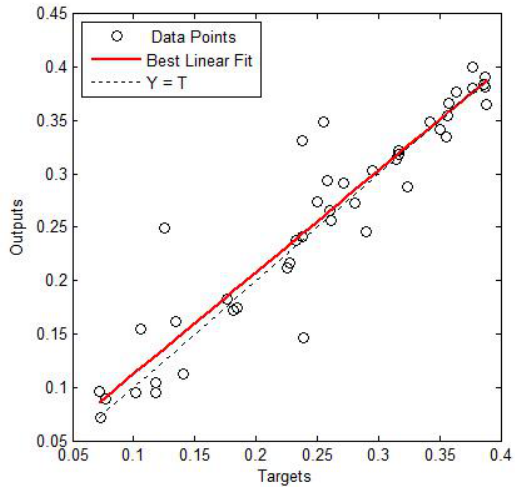
Fig. 4. Linear regression between the targets and outputs on the validation data set, R=0.934